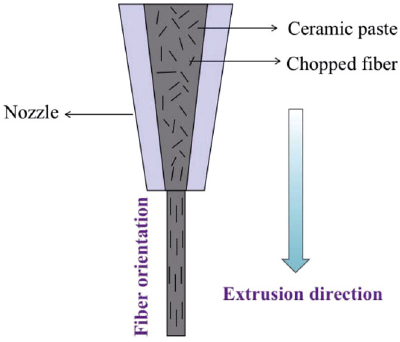
Fig. 21 Chopped carbon fiber orientation during EFF.